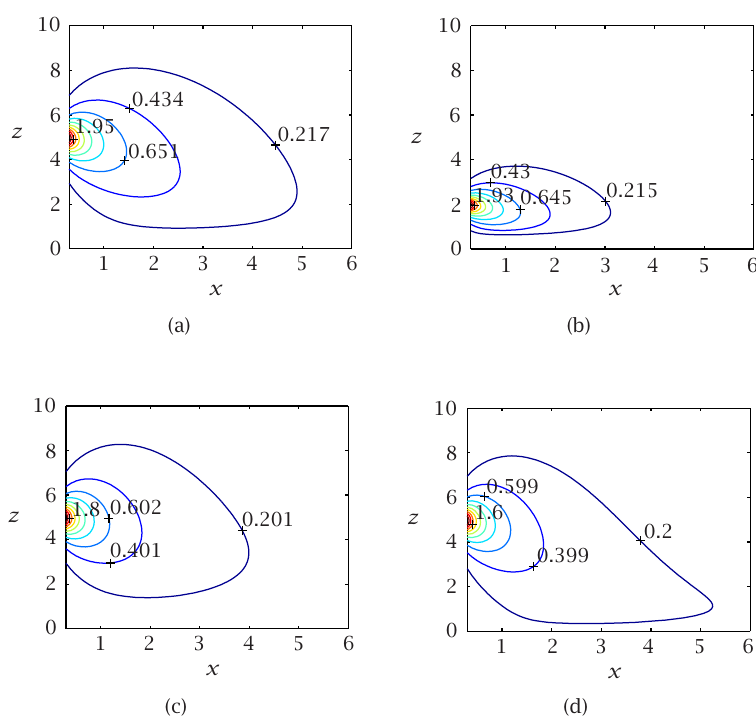
Figure 6.2 . The isolines of the concentration of the point source for different sets of values of parameters illustrating the effects of the parameters h , ν , b , and z o for a fixed value of time, t = 5 . 0. (a) h = 5 . 0, ν = 1 . 0, z o = 0 . 5, b = 1 . 0; (b) h = 2 . 0, ν = 1 . 0, z o = 0 . 5, b